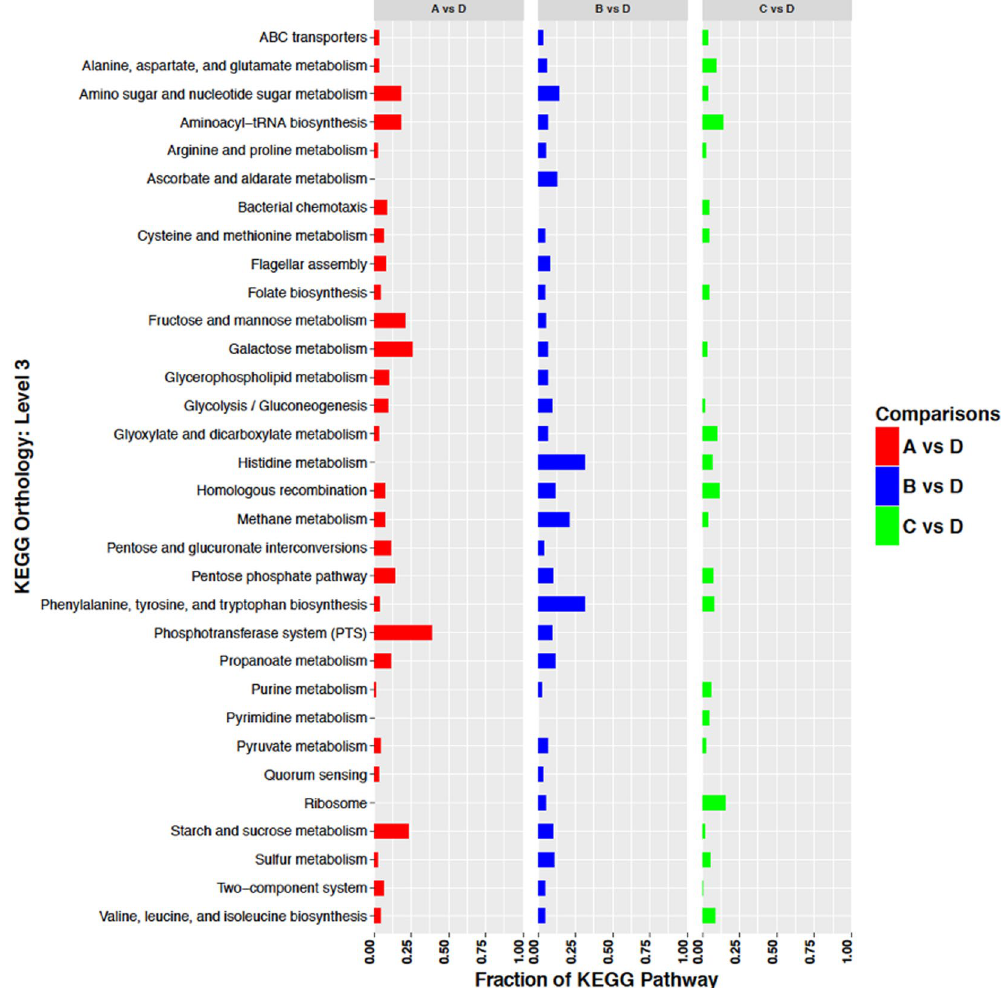
Figure 4. Up-regulated genes sorted by KEGG orthology. The number of genes of a particular KEGG pathway are depicted as a fraction of the total number of genes classified in that pathway in the genome of S. liquefaciens . See Table 1 for description of the